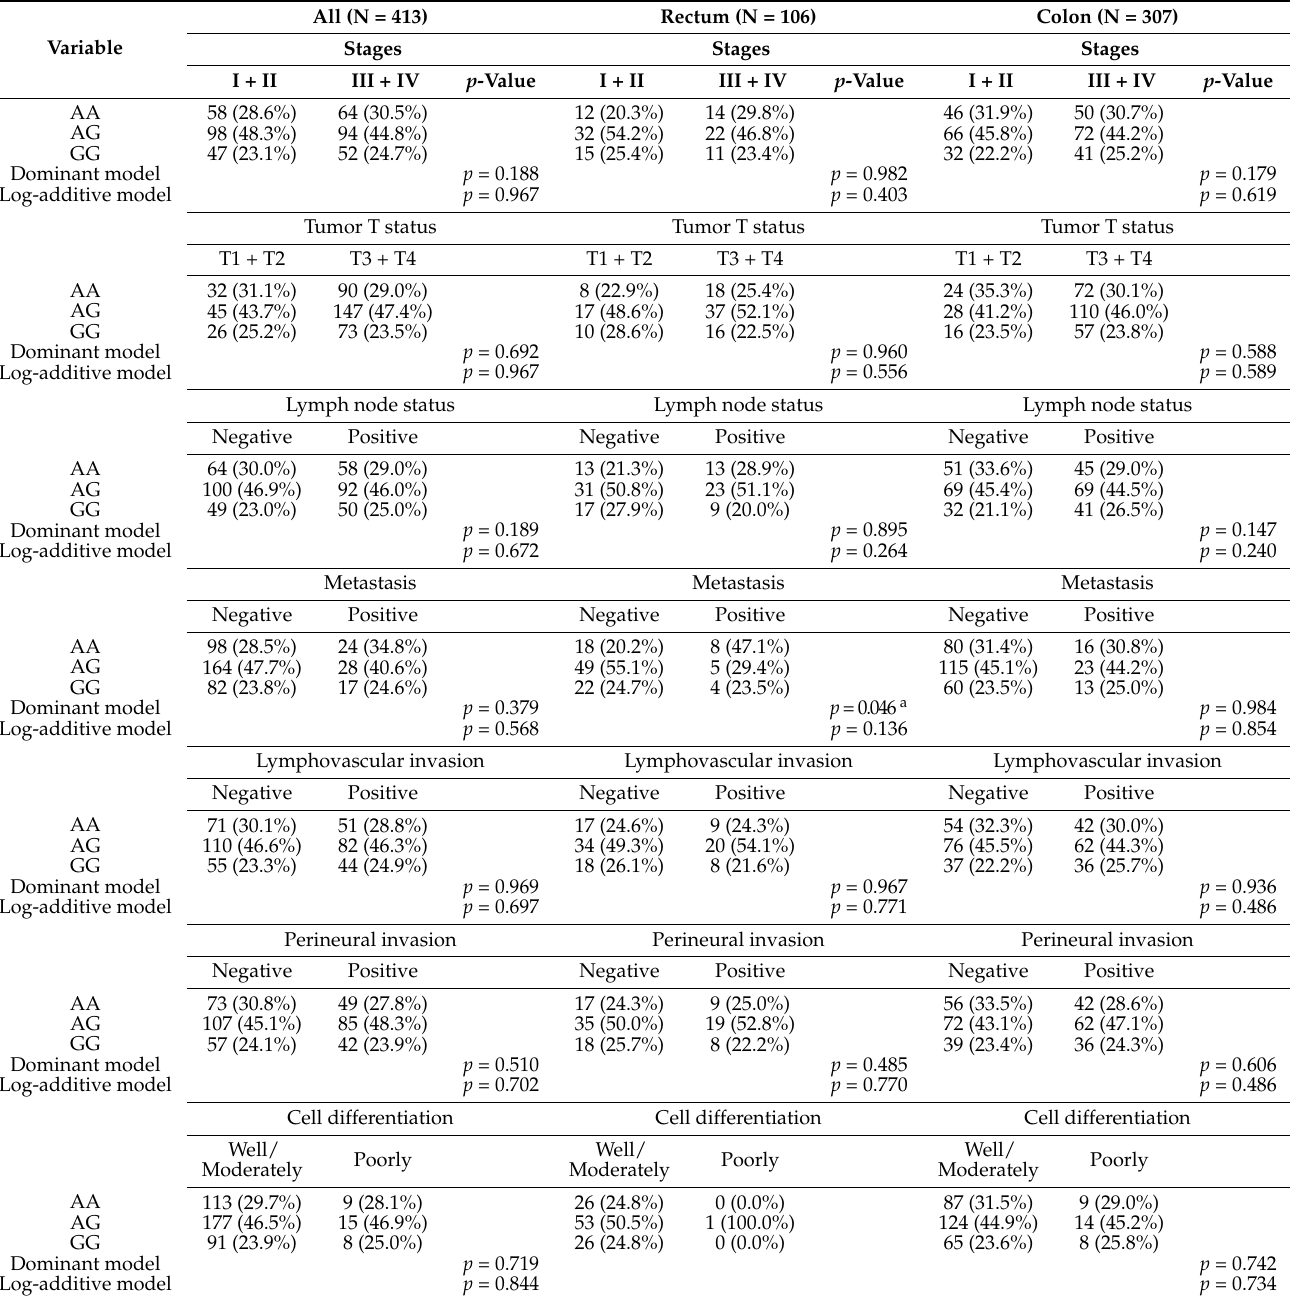
Table 3. Distribution frequency of the clinical status and FGFR4 rs1966265 genotype frequencies in 413 CRC